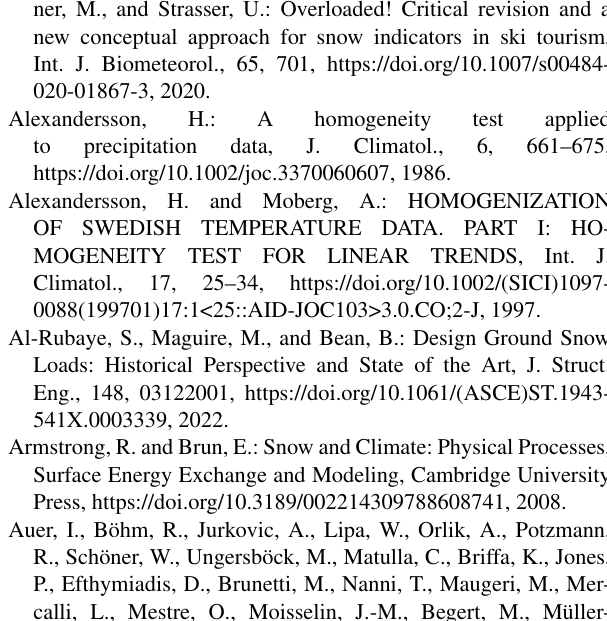
Figure A4. Range of the applied adjustment factors of interpQM for the different